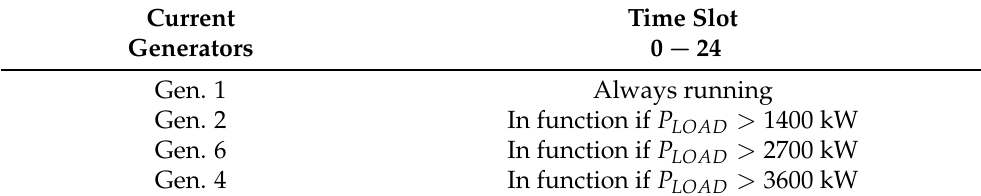
Table 14. Control logic of diesel groups in August.